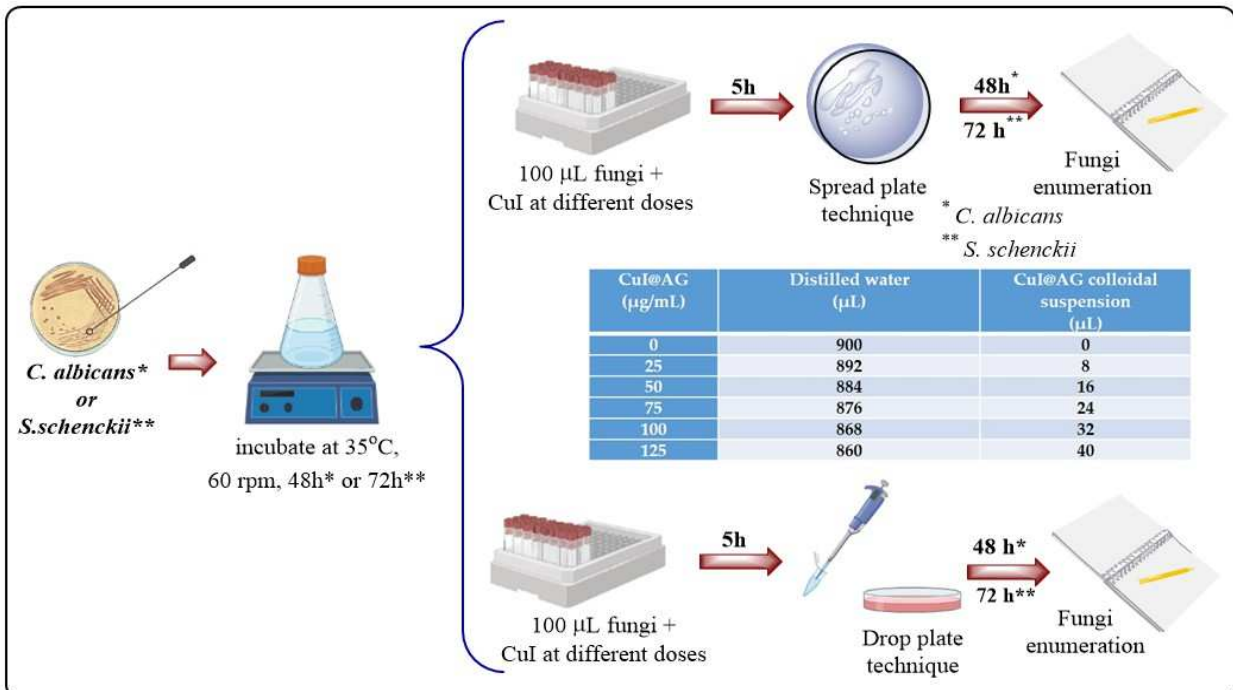
Figure 1. Schematic representation of the methodological approach for the evaluation of the antifungal activity of CuI@biopolymer against pathogenic fungi ( C. albicans , S. schenckii